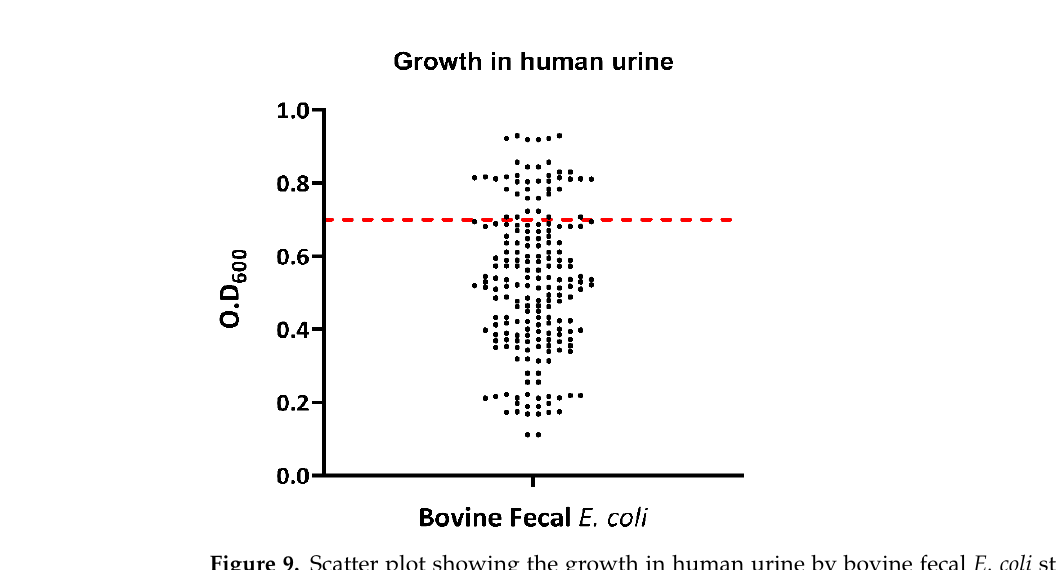
Figure 9. Scatter plot showing the growth in human urine by bovine fecal E. coli strains isolated from healthy cows. Dots represent each isolate’s optical-density value and the red line represents the standard O.D value required by the strains to be determined positive for growth in human urine; the strains at or above the red lines are positive for growth in human urine.